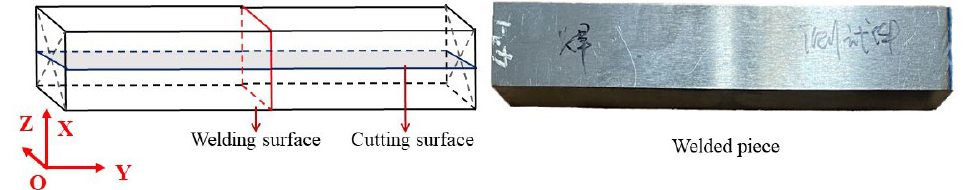
Figure 4. Schematic diagram of welding surface and cutting surface.